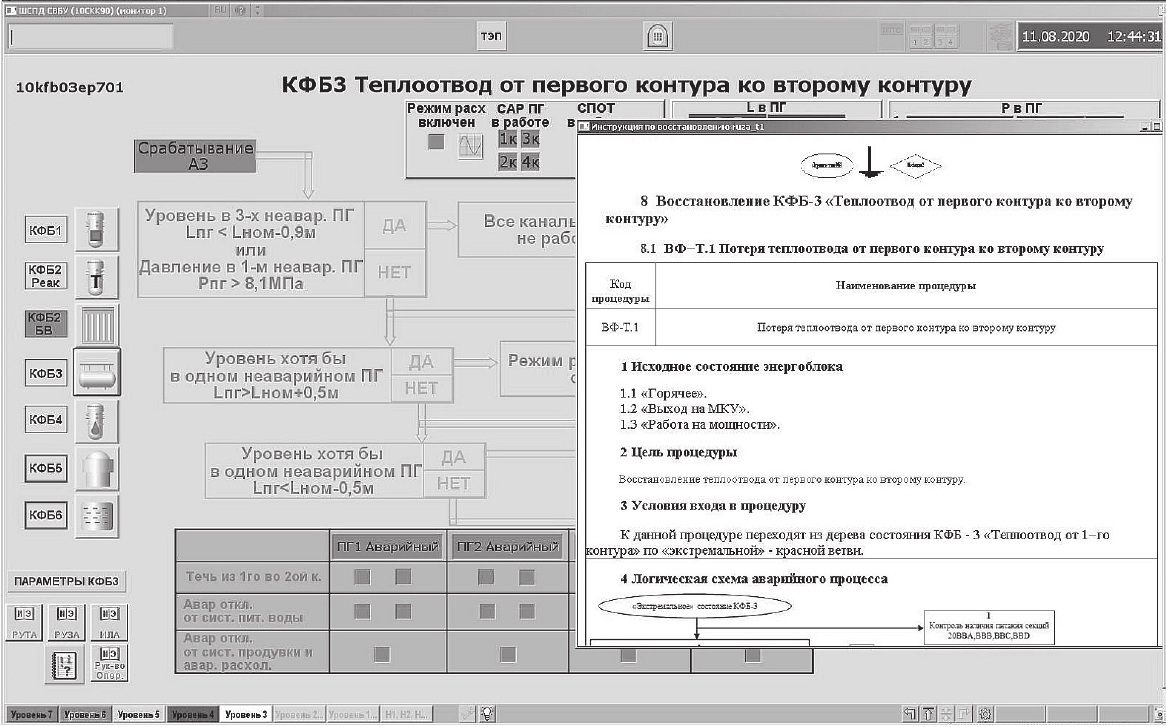
Figure 1. Critical safety functions in the